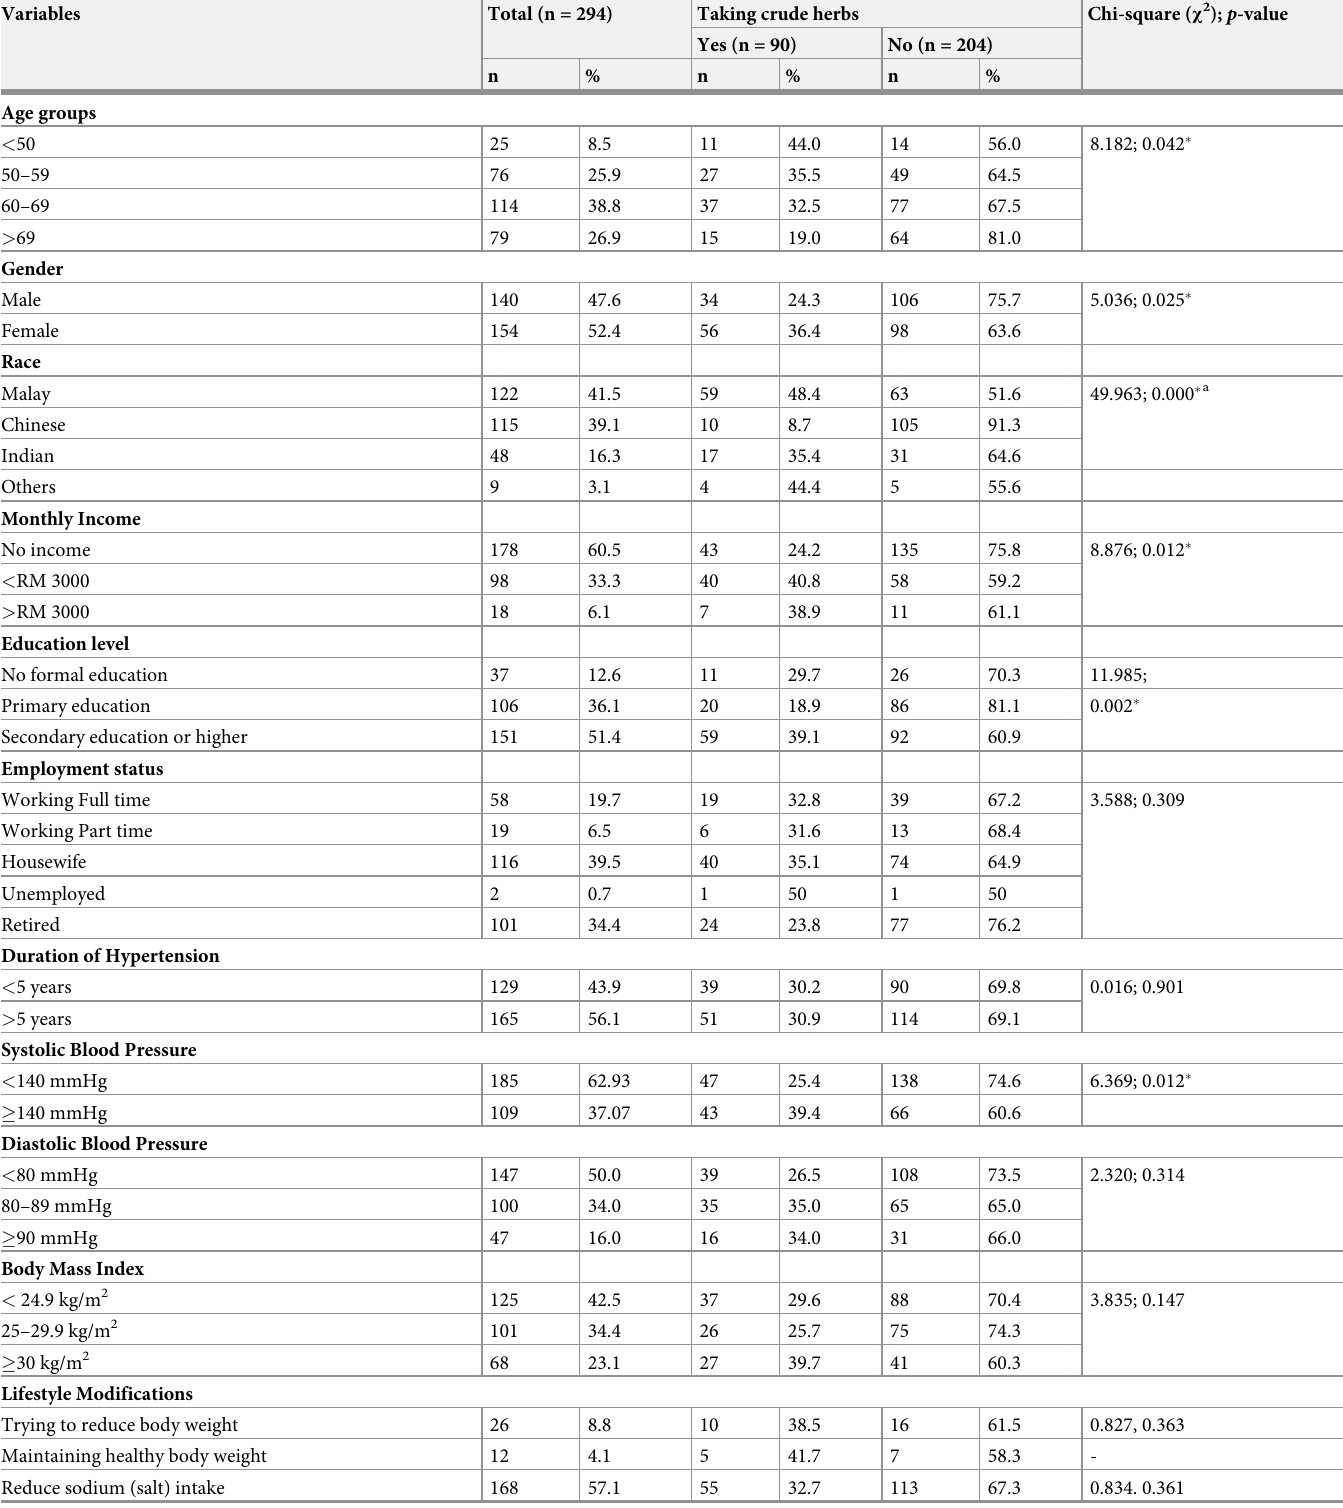
Table 1. The determinants of crude herbs use.